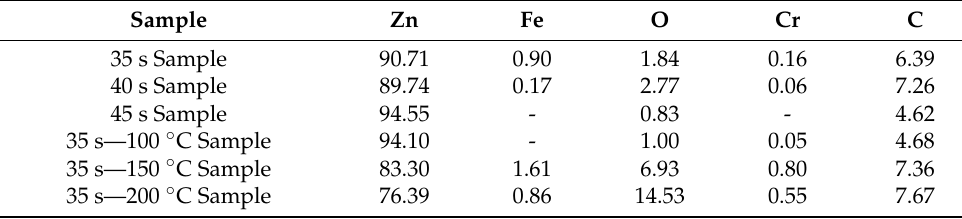
Table 2. The composition of position in Figures 8 and 9